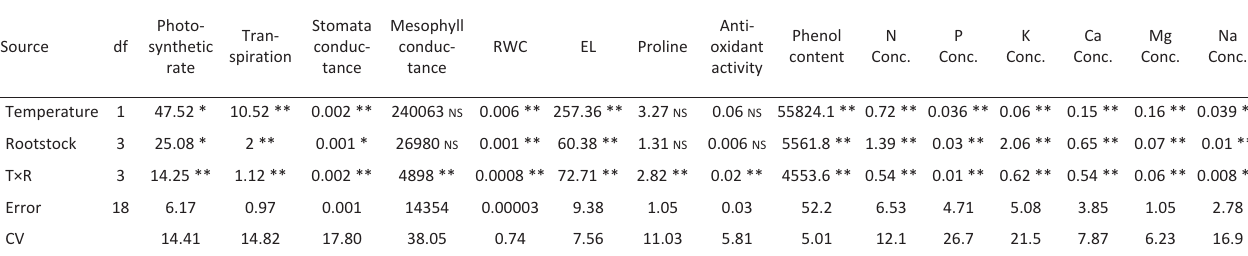
NS= no significant, * significant at 5% and ** significant at